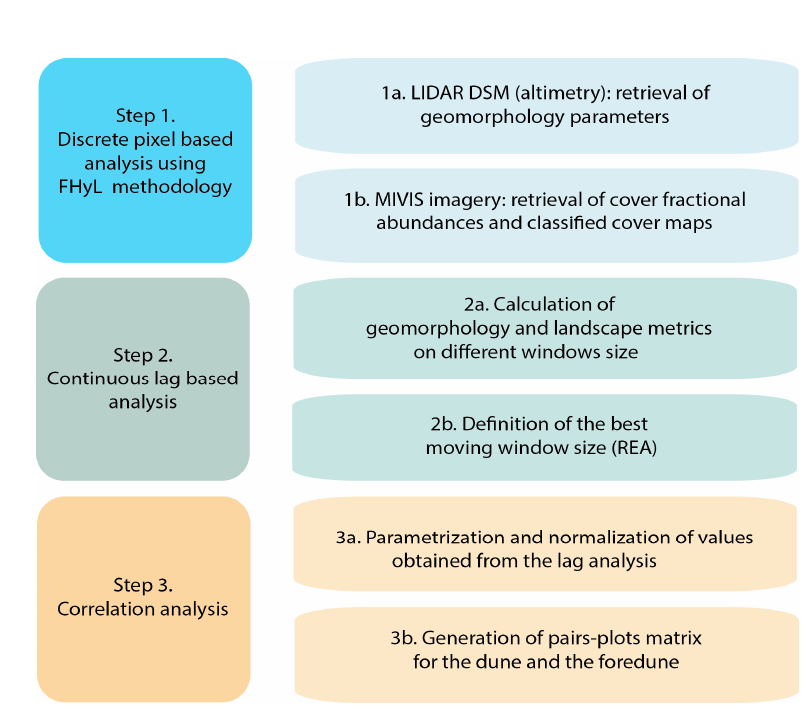
Figure 4. Implementation workflow.